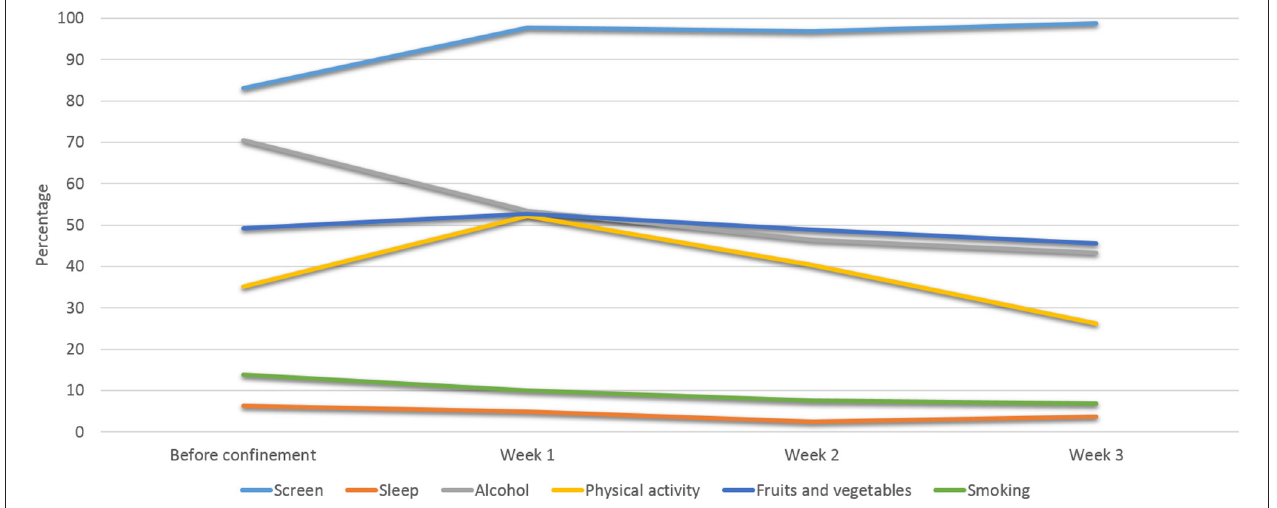
FIGURE 1 | Evolution of percentages of each health risk behavior during the COVID-19 confinement.